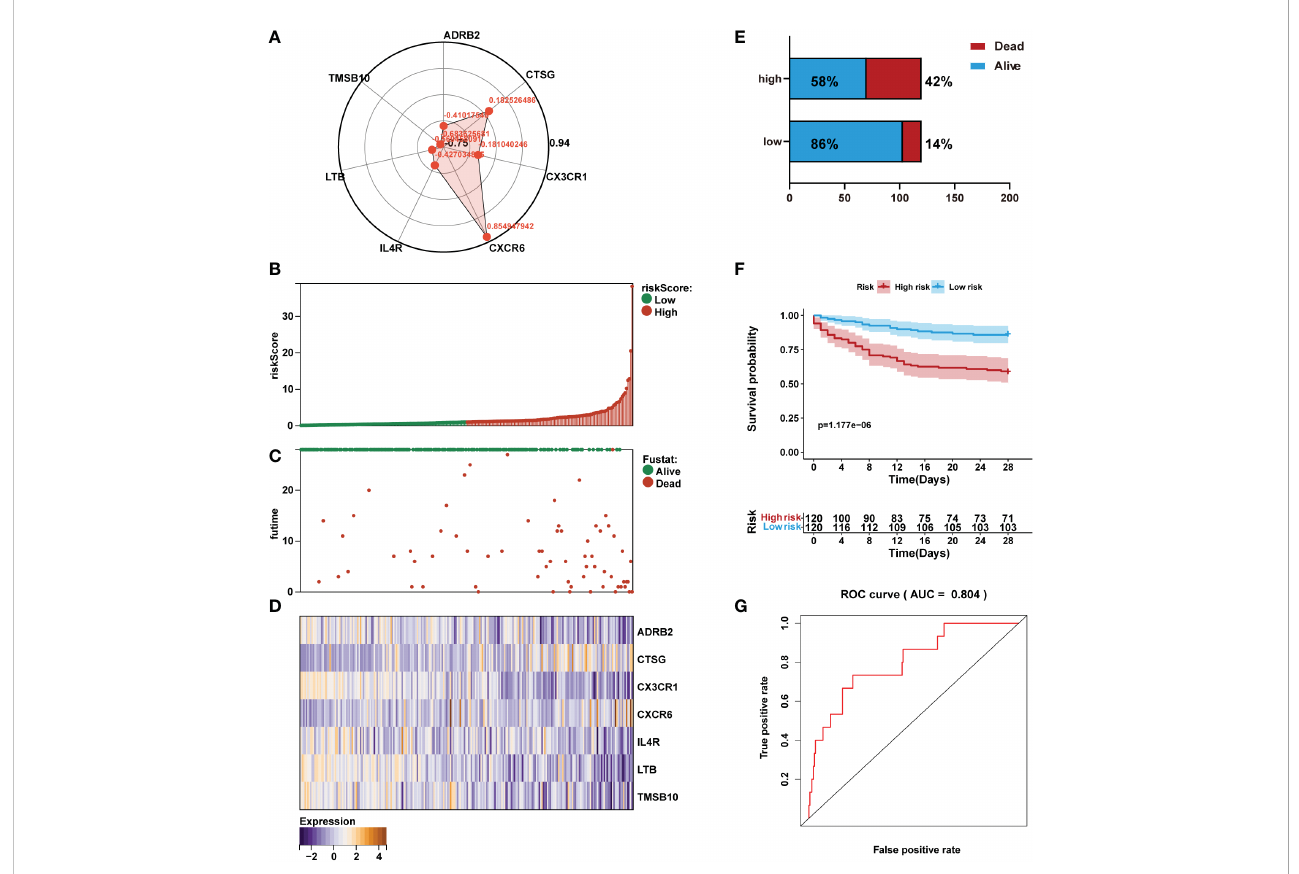
FIGURE 5 Prediction performance assessment of the prognostic signature in the training set (n=240). (A) Coef fi cient distribution of the gene signature. (B) Bar plot of a risk score for every patient and ordered by the value of risk score. (C) Distribution of vital survival status and risk scores of the immune signature. (D) Heatmap of the mRNA expression levels of the seven signature-comprising immune genes. (E) Comparison of survival risk between two groups. (F) Kaplan-Meier survival analysis of the gene signature in the training set. (G) ROC curves of the seven-mRNA signature in